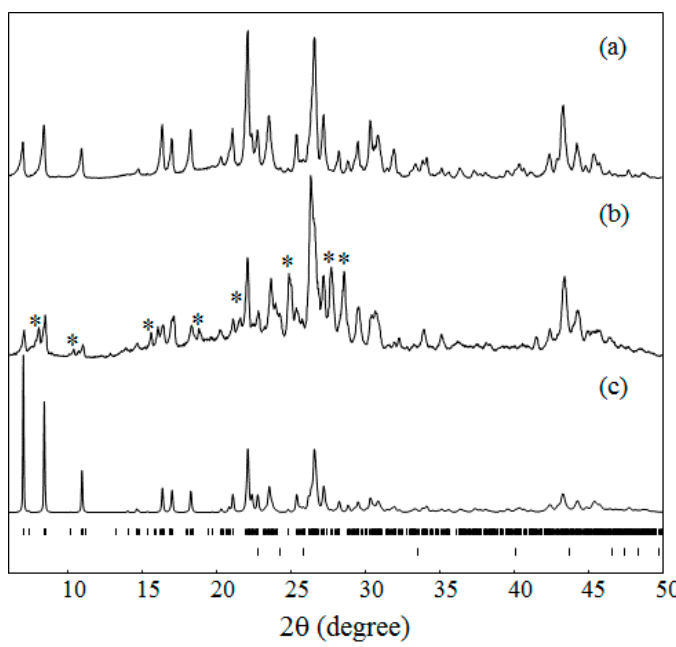
Figure 3. X-ray diffraction patterns of TBAB semi-clathrate hydrate (SC). Upper tick marks under powder X-ray diffraction (PXRD) profile represent calculated peak locations for the SC and lower tick marks represent those for hexagonal ice. ( a ) TBAB + CO 2 + N 2 SC at 93 K; ( b ) TBAB SC without CO 2 + N 2 gas at 93 K; and ( c ) orthorhombic TBAB SC without CO 2 + N 2 gas simulation [26]. Asterisks (*) represent diffraction peaks other than orthorhombic phase.